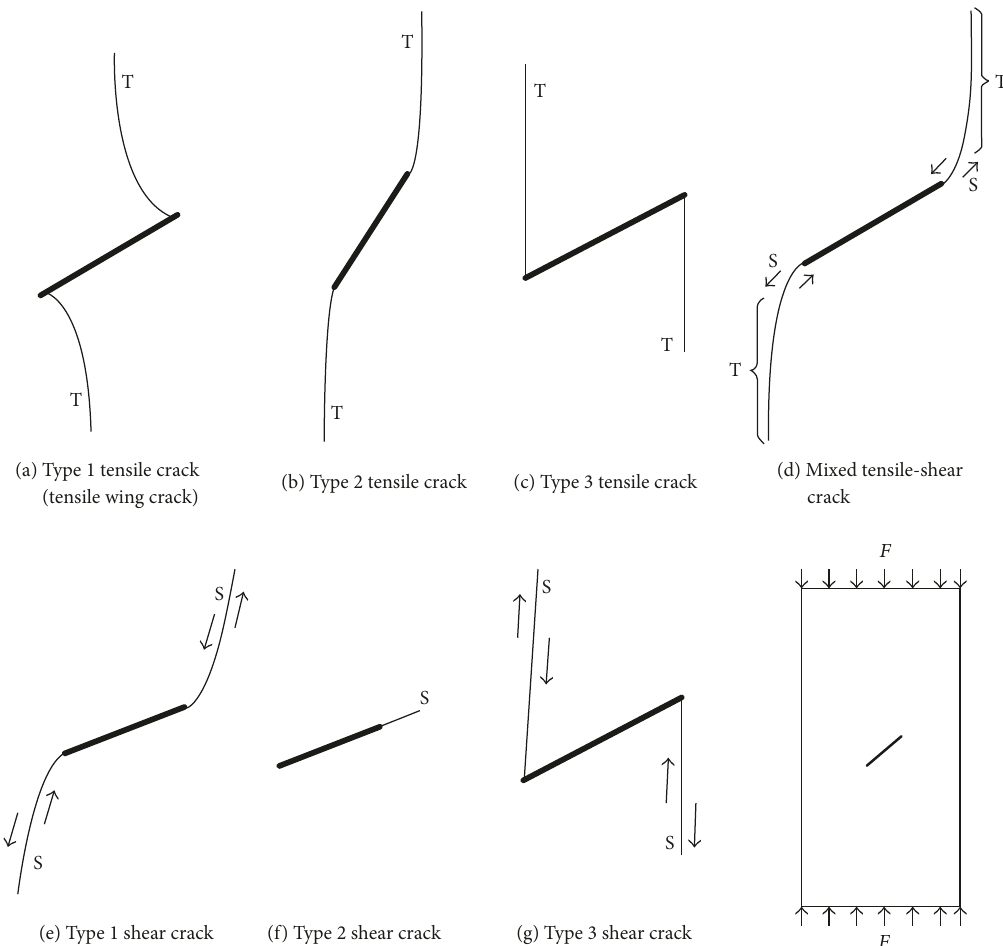
Figure 13: The crack types initiated from the preexisting flaws (T: tensile crack opening, S: shearing displacement).